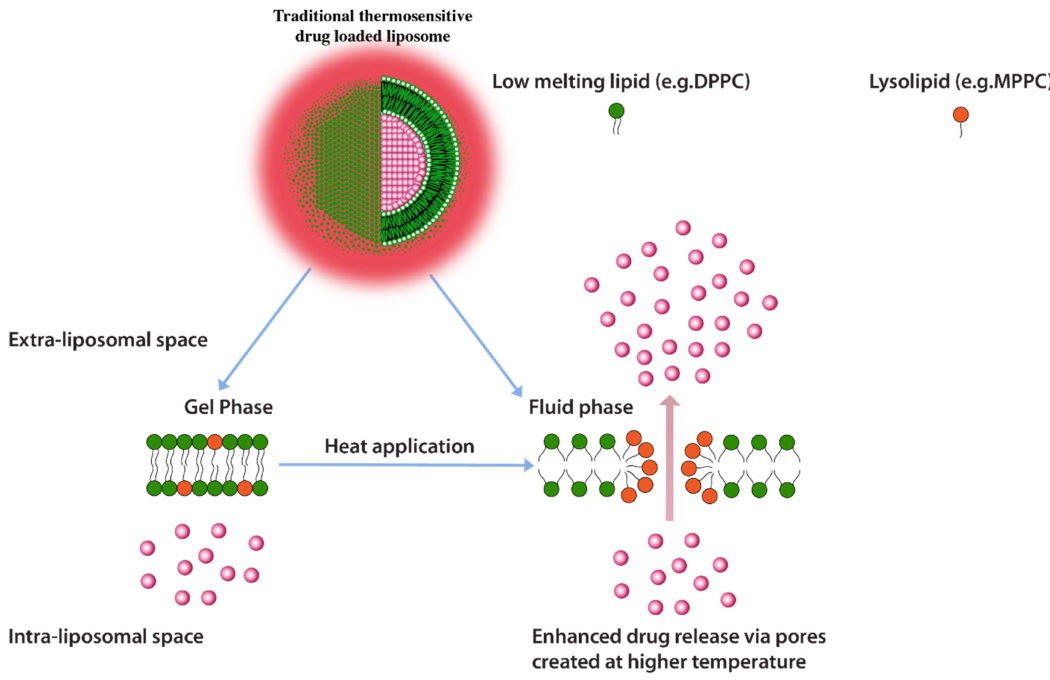
Figure 10. Traditional thermosensitive drug loaded liposomes showing formation of micellar pockets upon application of